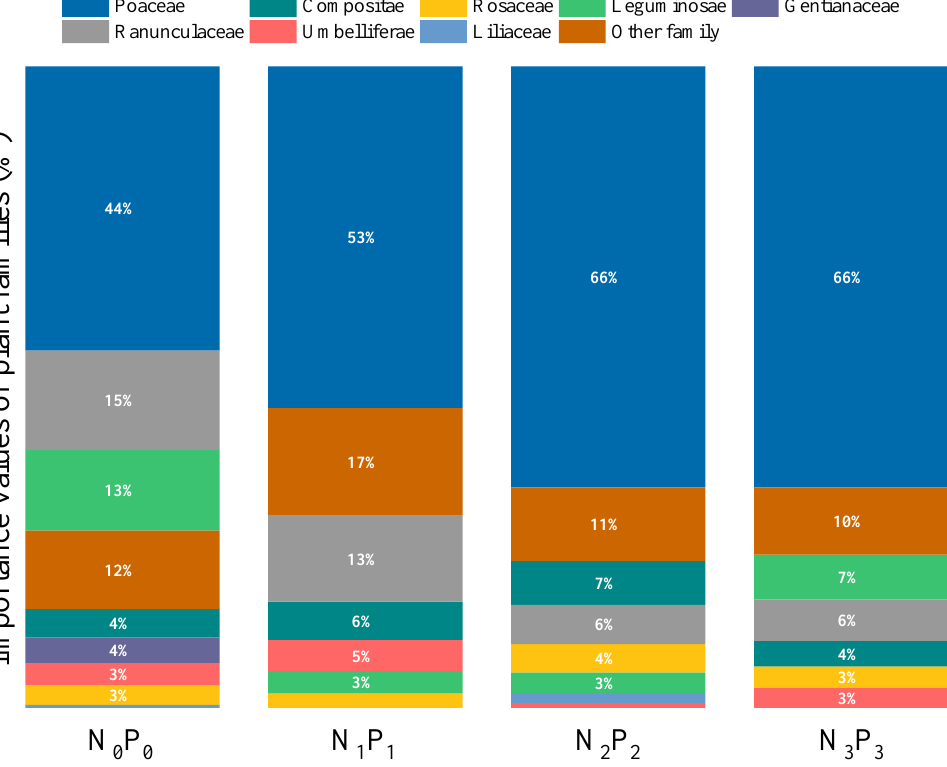
Figure 4. Importance values of plant families among N and P addition treatments. The basic unit of plant classification is the species, and some species with more commonalities are grouped into families. We classify plants according to families, which can represent the different functional groups of plants.